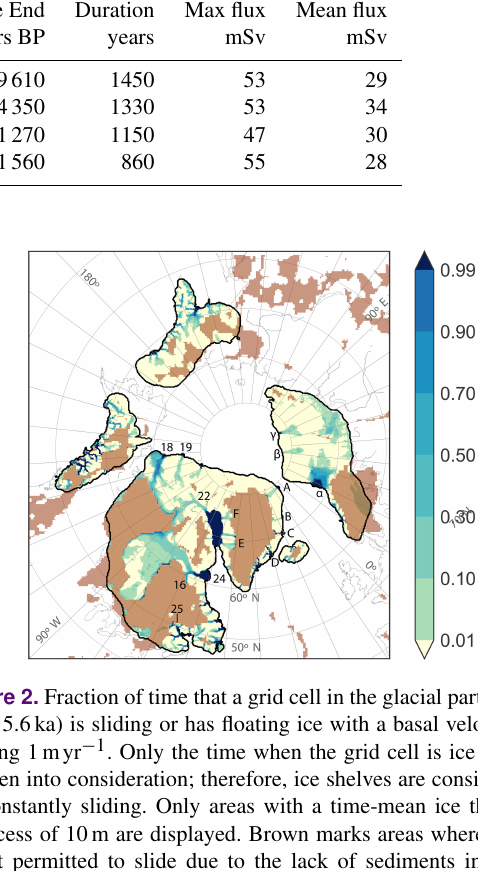
ice streams. In the Baltic Sea, the ice sheet retreats at the start of the experiment, so there is temporarily an ice shelf. Stereographic projection around 71 ◦ N, 44 ◦ W with grid lines at multiples of 10 ◦